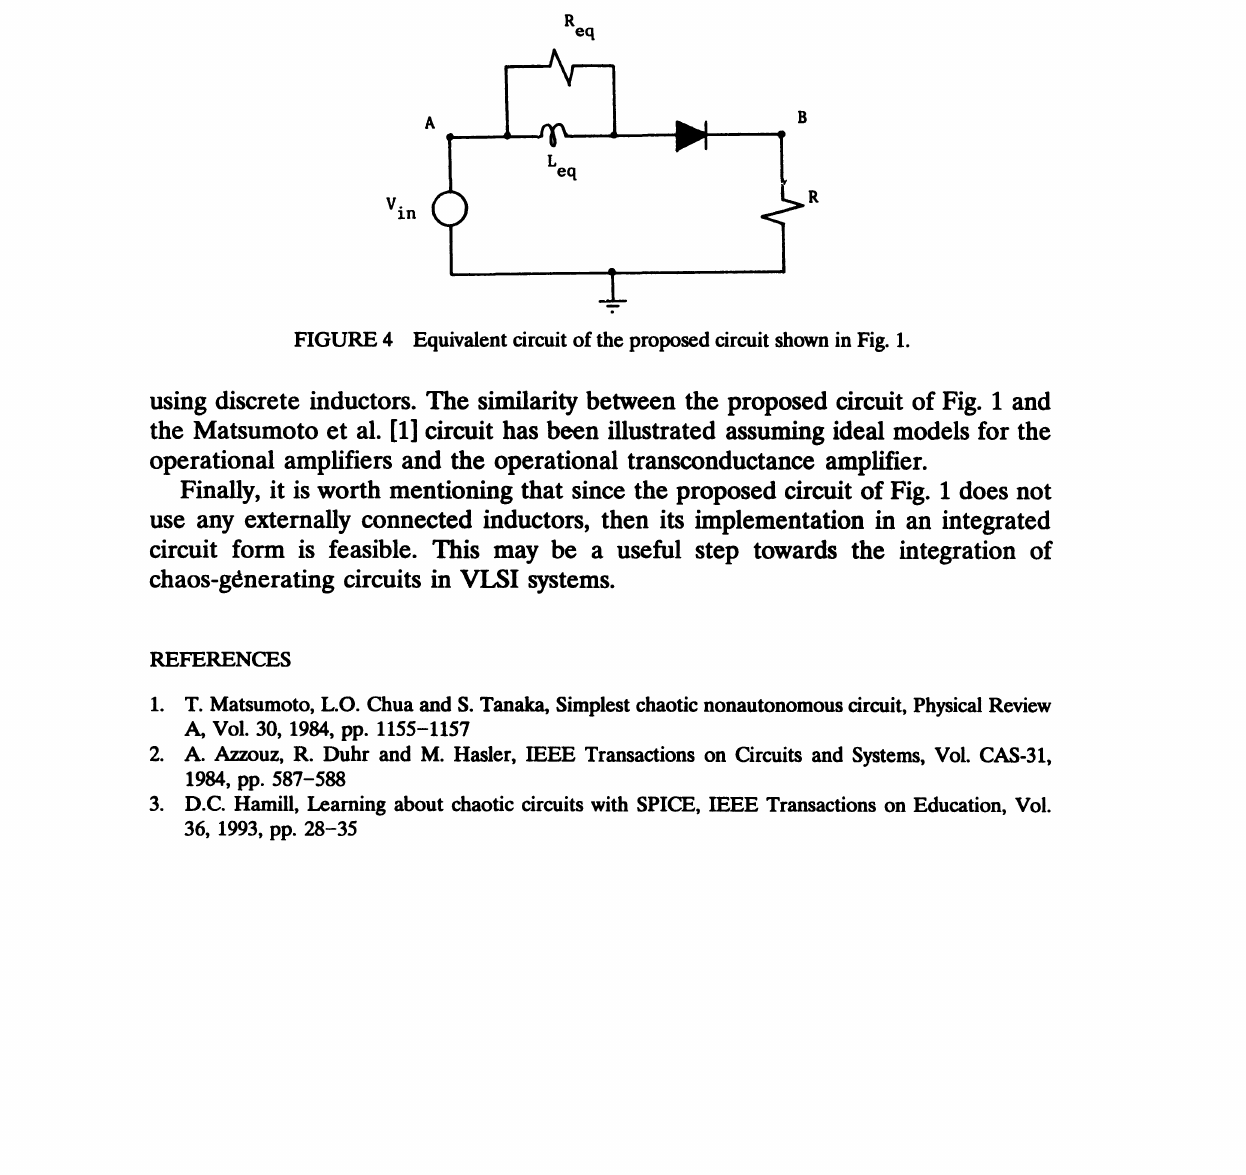
FIGURE 3 Circuit used for inductor simulation g,. R